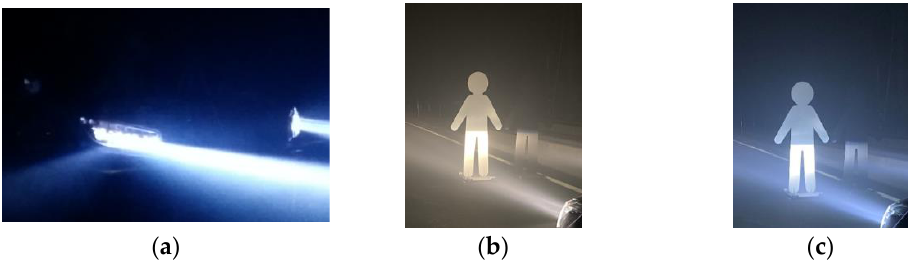
Figure 1. Color temperature convertible headlamps in operation: ( a ) Headlamp lighting in operation in foggy conditions; ( b ) 3000 K lighting; ( c ) 6000 K